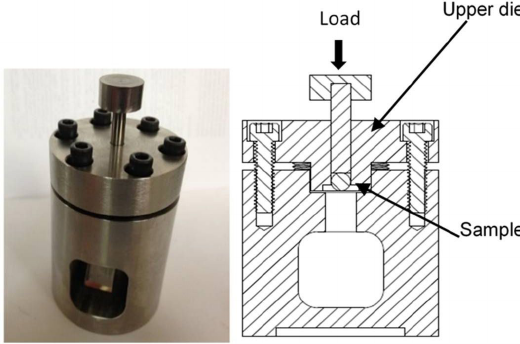
Figure 5. Small punch test (SPT)